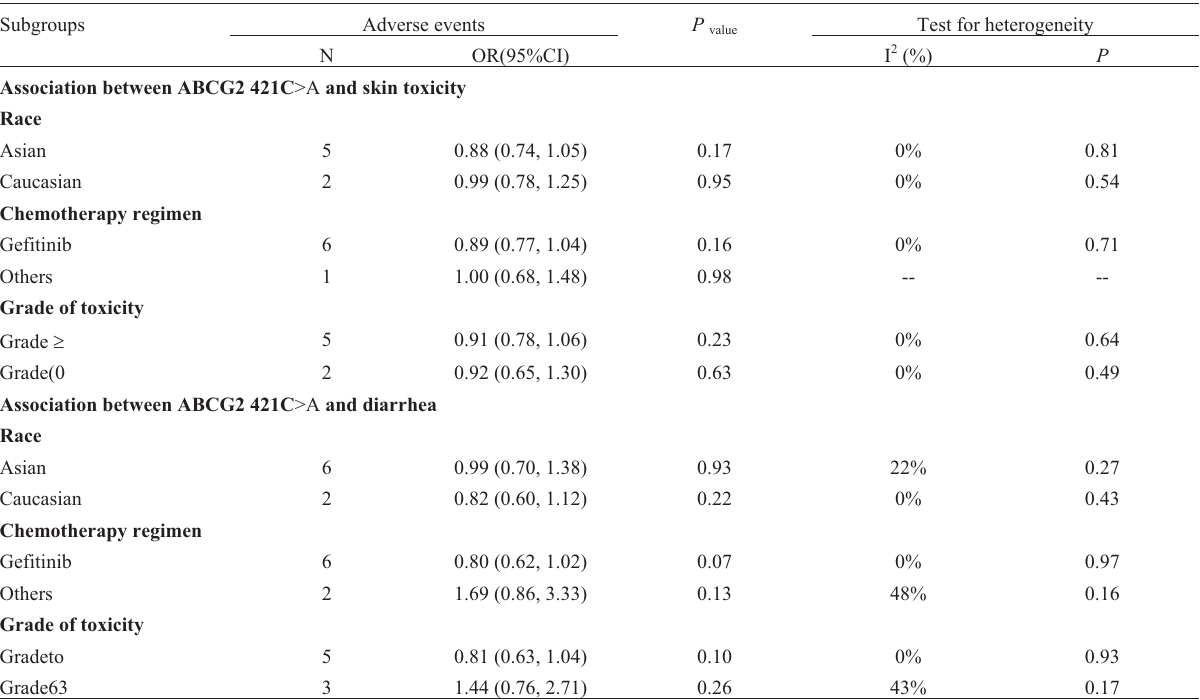
Table 3 - Subgroup analyses of ABCG2 421C>A (AA+CA vs.